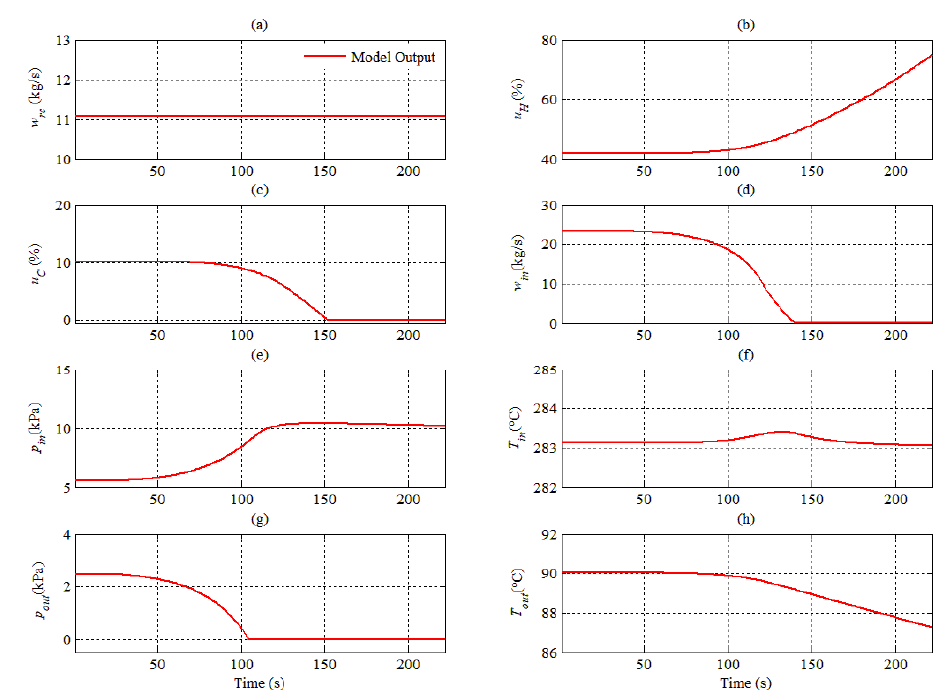
Figure 5. Simulation of coal blockage